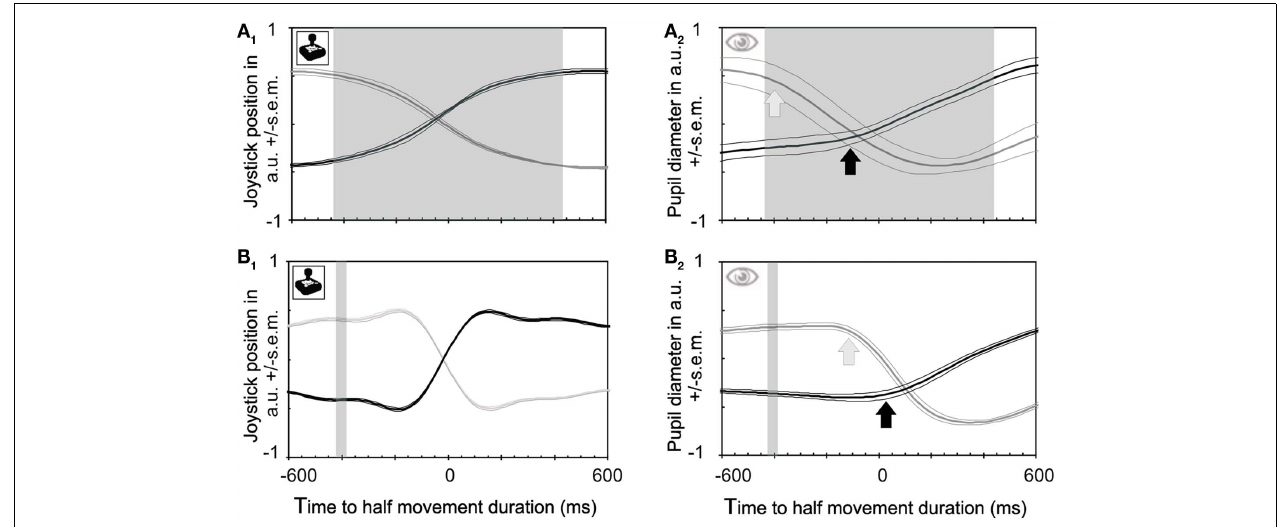
FIGURE 2 | Joystick and pupil responses obtained during binocular rivalry and between stimuli of differing luminances. (A ) Joystick position and pupil responses to subjective changes in perceived grating orientation relative to joystick responses.Time zero is defined as half of the movement duration (not the mid position of the joystick which occurs earlier).This midpoint corresponds rather well with the time of button presses. (A 1 ) Joystick position.The transition between the two percepts requires on average 928ms in both directions (shaded area), and joystick responses start about 460ms (left side of shaded area) before the joystick reaches its midpoint, mirroring the relative slowness of the perceptual transition. (A 2 ) Pupil constrictions (which are known to be faster than dilations, Miller et al.,